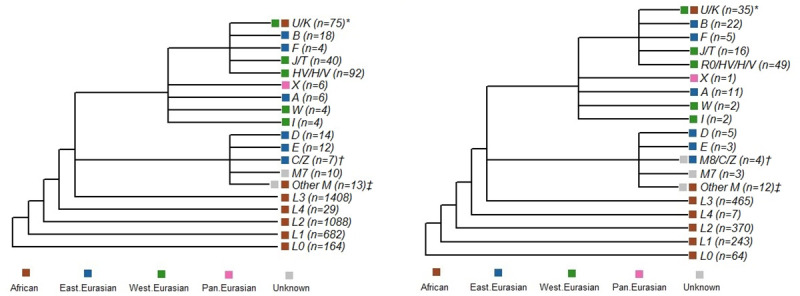
Mitochondrial haplogroup distributions.Shown are the mitochondrial haplogroup distributions of the 3,676 SAPPHIRE participants (A) and the 1,319 SAGE II participants (B). Branching shows haplogroup derivation and color coding denotes the geographic identity of the haplogroup. *In SAPPHIRE this group consisted of 34 individuals with an African haplogroup (U6) and 41 with a west Eurasian haplogroup (U2, U3, U4, U5, U7, and K), and in SAGE II this group consisted of 16 individuals with an African haplogroup (U6) and 19 with a west Eurasian haplogroup (U4, U5, U8, and K). †In SAPPHIRE this group consisted of 7 individuals with an east Eurasian haplogroup (C, Z), and in SAGE II this group consisted of 3 individuals with an east Eurasian haplogroup (C, Z) and 1 individual with a haplogroup of unknown origin (M8). ‡In SAPPHIRE this group consisted of 2 individuals with an African haplogroup (M1) and 11 individuals with a haplogroup of unknown origin (M2, M23, M30, and M32), and in SAGE II this group consisted of 6 individuals with an African haplogroup (M1) and 6 individuals with a haplogroup of unknown origin (M3, M5, M6, and M23).